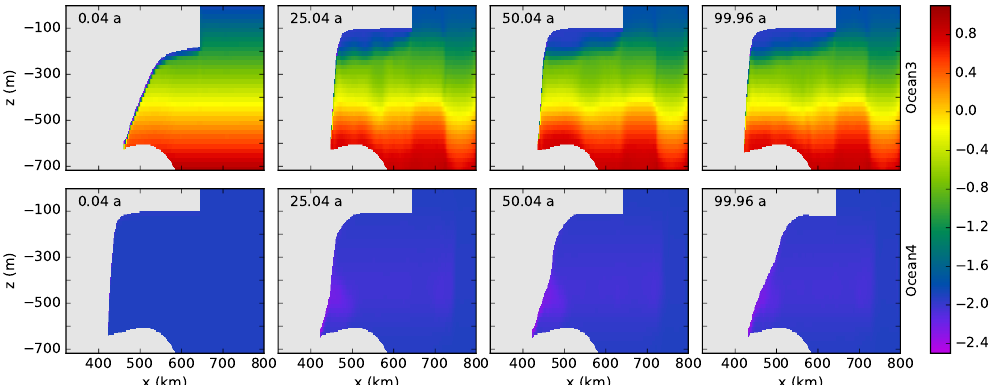
Figure 11. Example results from POP2x as in Fig. 8 but for Ocean3 (top) and Ocean4 (bottom) simulations each lasting 100 years. In these experiments, the ice draft evolves in time. Ocean3 prescribes WARM initial conditions and restoring, producing strong melting throughout the experiment, consistent with the retreating ice. The melt rate declines slightly over the course of the simulation as the ice retreats to shallower depths, associated with colder ocean temperatures. Ocean4 is initialized and forced with COLD profiles, which lead to relatively low melt rates, fitting with the advancing ice topography. Meltwater cools the sub-shelf cavity, leading to several decades of decreasing melt rates followed by quasi-steady values for the remainder of the